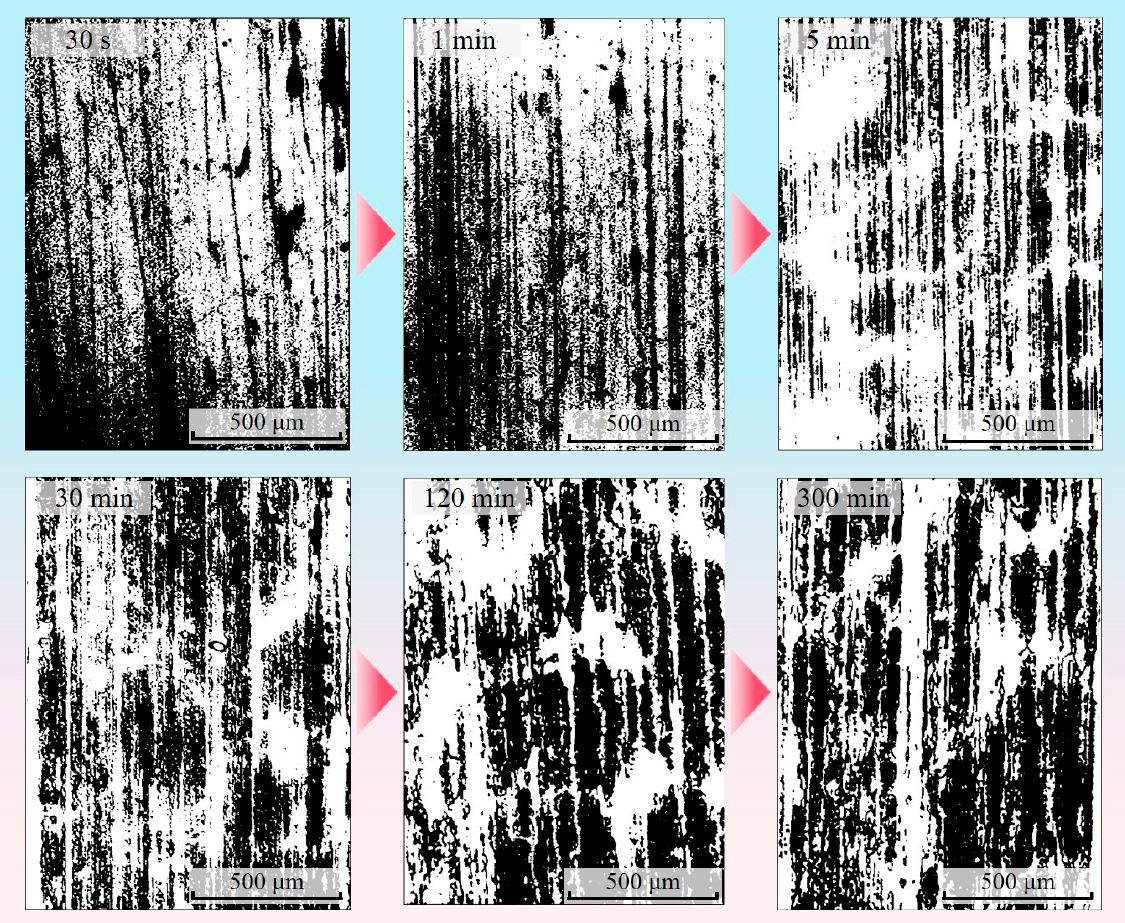
Figure 7. Binary images of the transfer film at different friction stages.